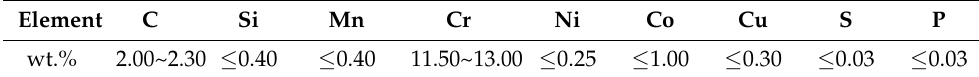
Table 3. Chemical composition of